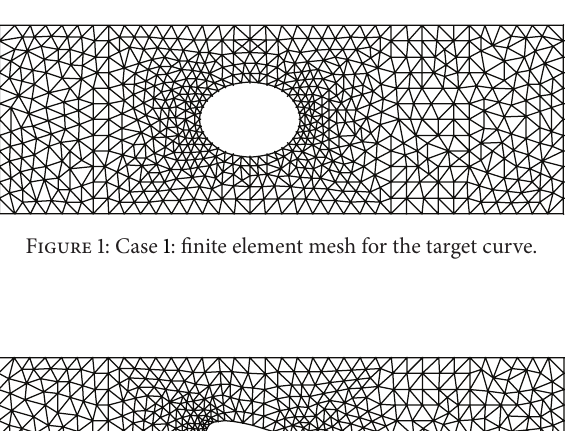
Figure 5: Case 2: 𝑡 = 0.15 , reconstruction of a cone-shaped curve.